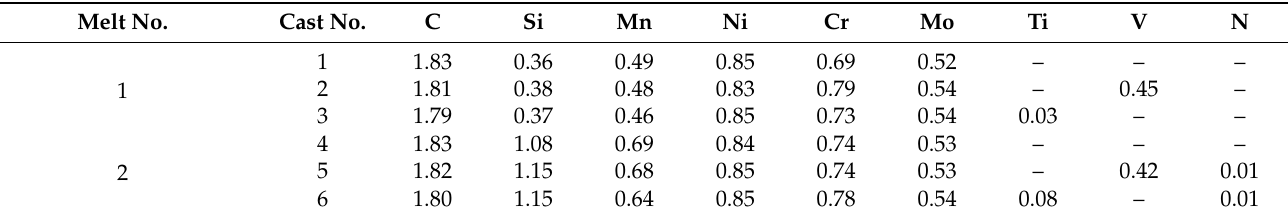
Table 1. Chemical composition of the hypereutectoid steel (wt.%). Melt No. Cast